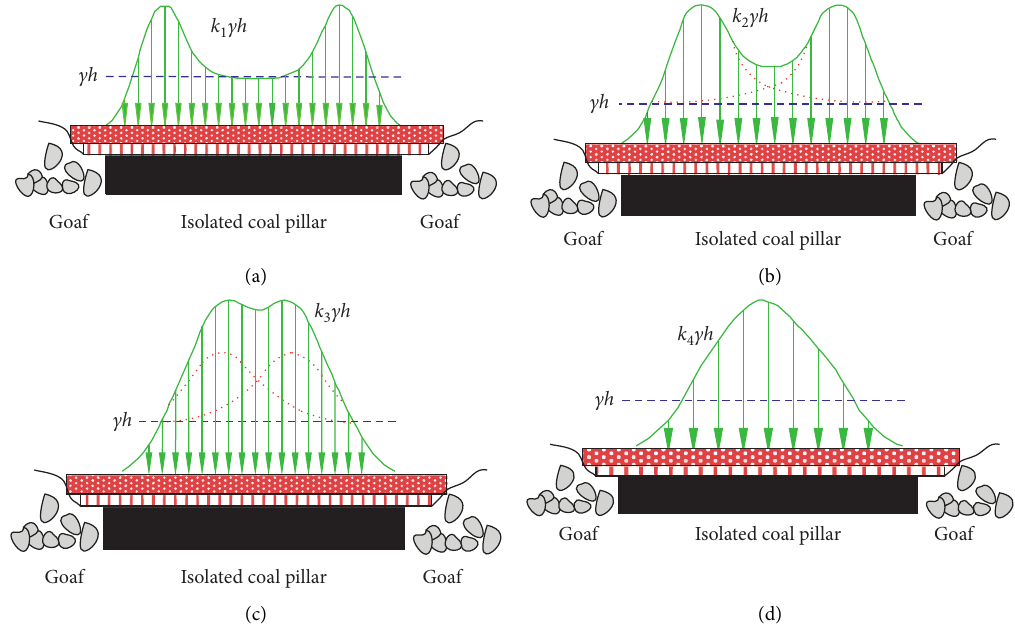
Figure 8: Distribution of superimposed stress field in isolated coal pillar area: (a) double peak; (b) saddle-shaped; (c) platform-shaped; (d) single peak.